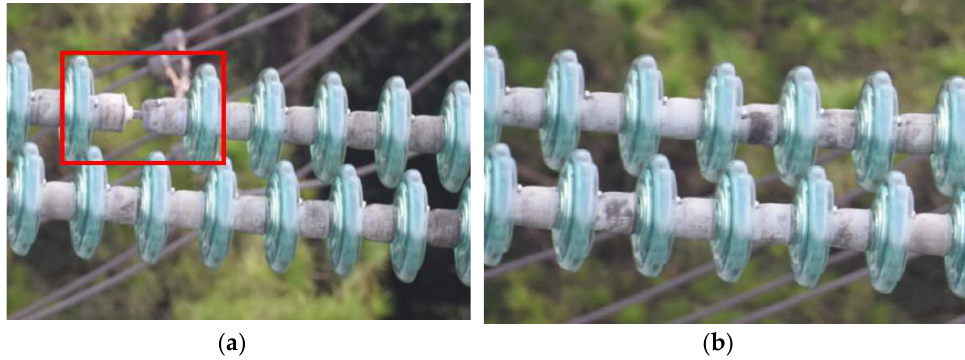
Figure 17. Examples of health insulators and insulators with defects. ( a ) Insulator with defects. ( b ) Health insulator.